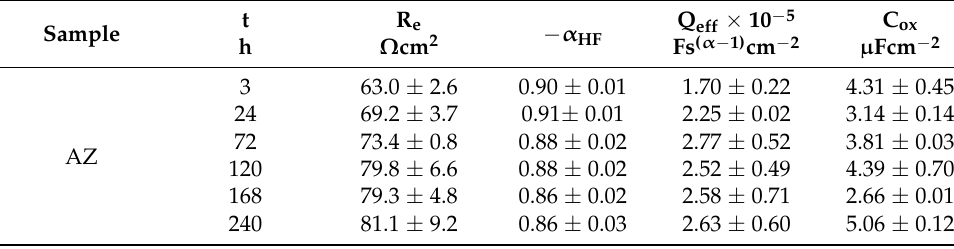
Table 3. Impedance parameter obtained graphically for AZ31 alloy in Na 2 SO 4 0.1 M.